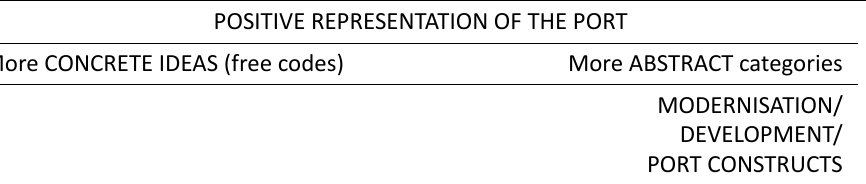
Table 1. Cultural representations of the port‐city